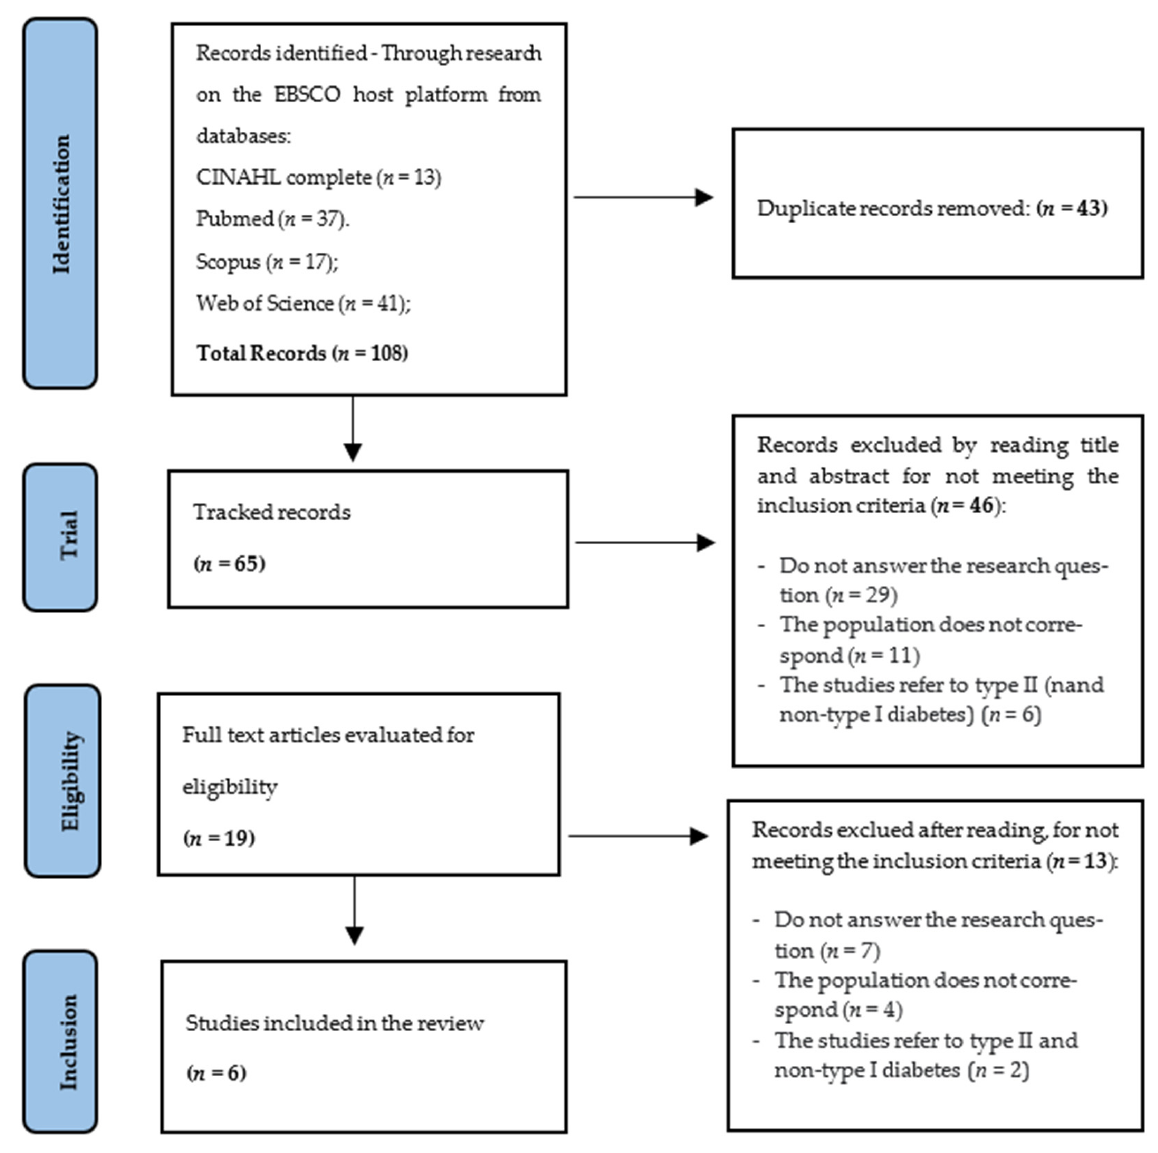
Figure 1. Flowchart based on the PRISMA model.